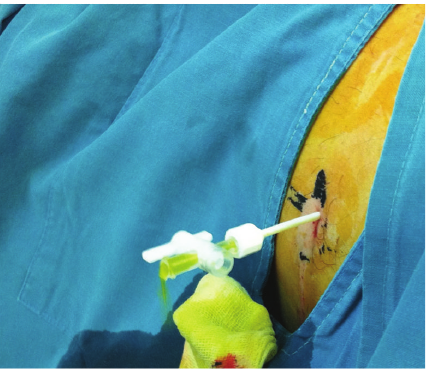
Figure 5: Bile-stained fluid drawn by the catheter upon